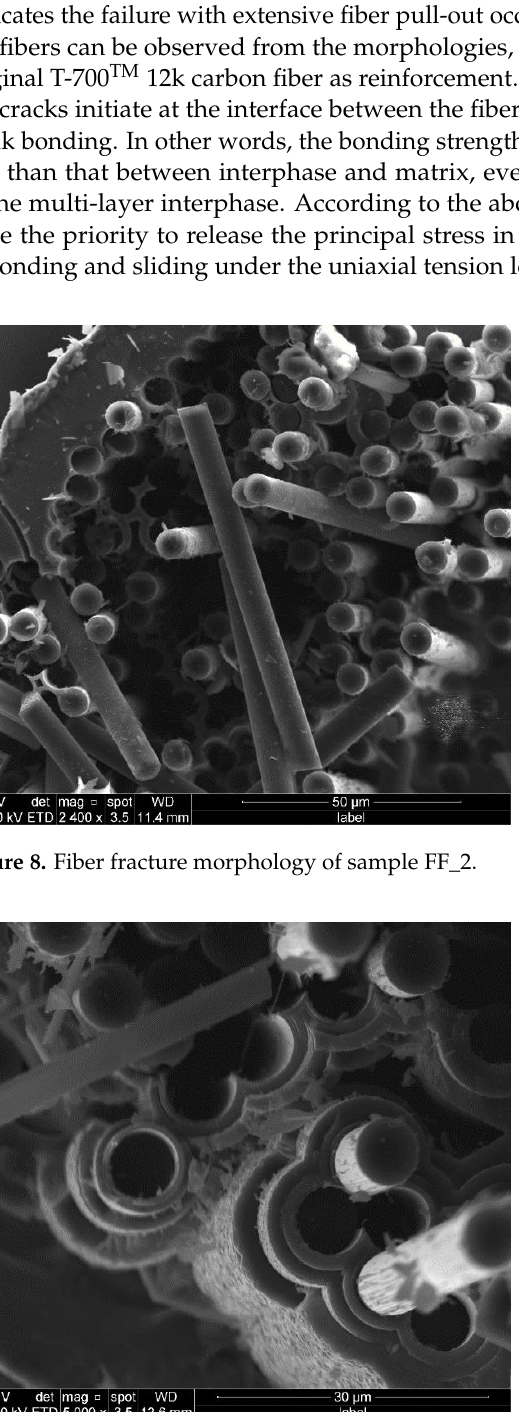
Figure 7. Fracture morphologies of sample NC_2.